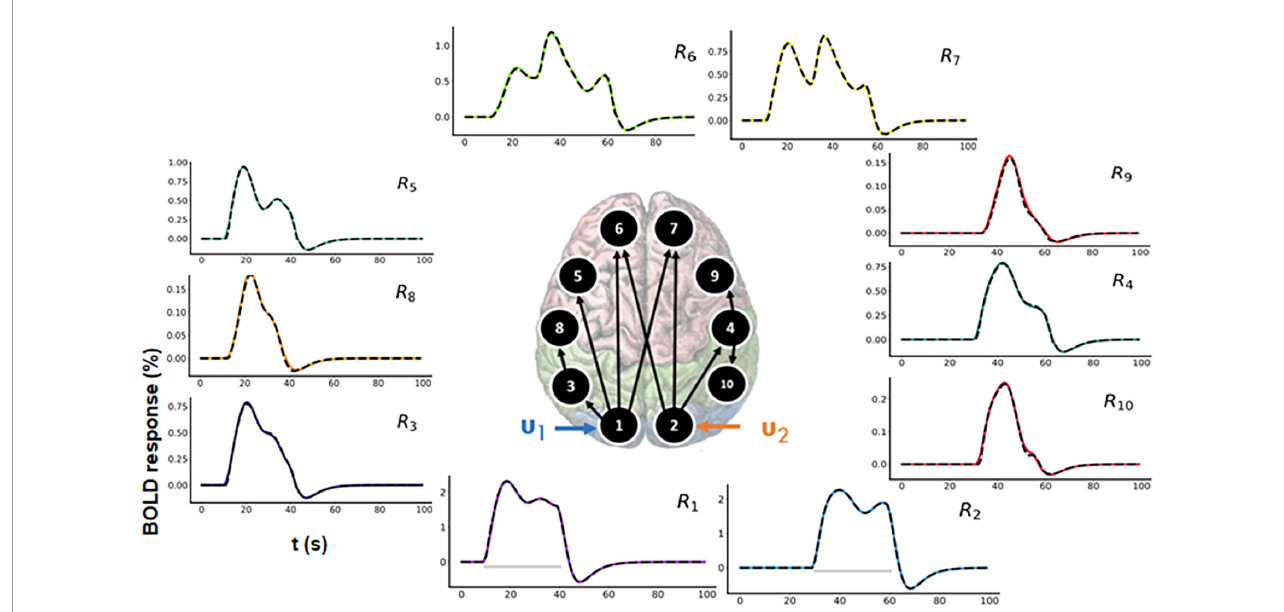
FIGURE6 Functional magnetic resonance imaging (fMRI) blood oxygenation level-dependent (BOLD) time courses for 10-region model where connections exist between R1 to R3, R3 to R8, R1 to R5, R1 to R6, R1 to R7, R2 to R6, R2 to R4, R4 to R9, and R4 to R10. Two time-varying inputs u 1 and u 2 are applied to R1 and R2, respectively. The black dashed lines represent the predicted responses, and the colored lines represent the simulated time courses.